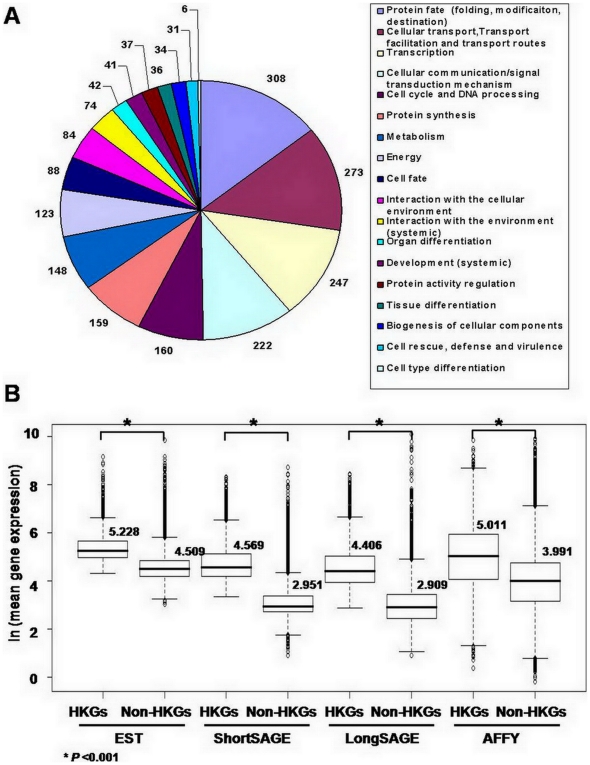
Characterization of candidate HKGs identified in this study.(A) The functional distribution of candidate HKGs was classified by FunCat. Among the 2,087 UniGene clusters, a total of 1,605 UniGene clusters which have GO terms under biological processes were classified according to their major functional categories using FunCat (version 2.0) by mapping the GO terms to FunCat categories. A total of 1,318 UniGene clusters were classified by FunCat. The number of UniGene clusters belonging to each category is presented in A. In some cases, UniGene clusters mapped to two or more FunCat categories. (B) Comparison of gene expression between candidate HKGs and non-HKGs in each dataset. Box and Whisker plots provide a simple description of a distribution of values by depicting the 25th and 75th percentile values as the bottom and top of a box, respectively. The Y axis represents the natural logarithm transformed mean gene expression levels. The median expression values of HKGs and non-HKGs are marked by horizontal lines in the boxes and the values are provided to the right of each box. *P<0.001.